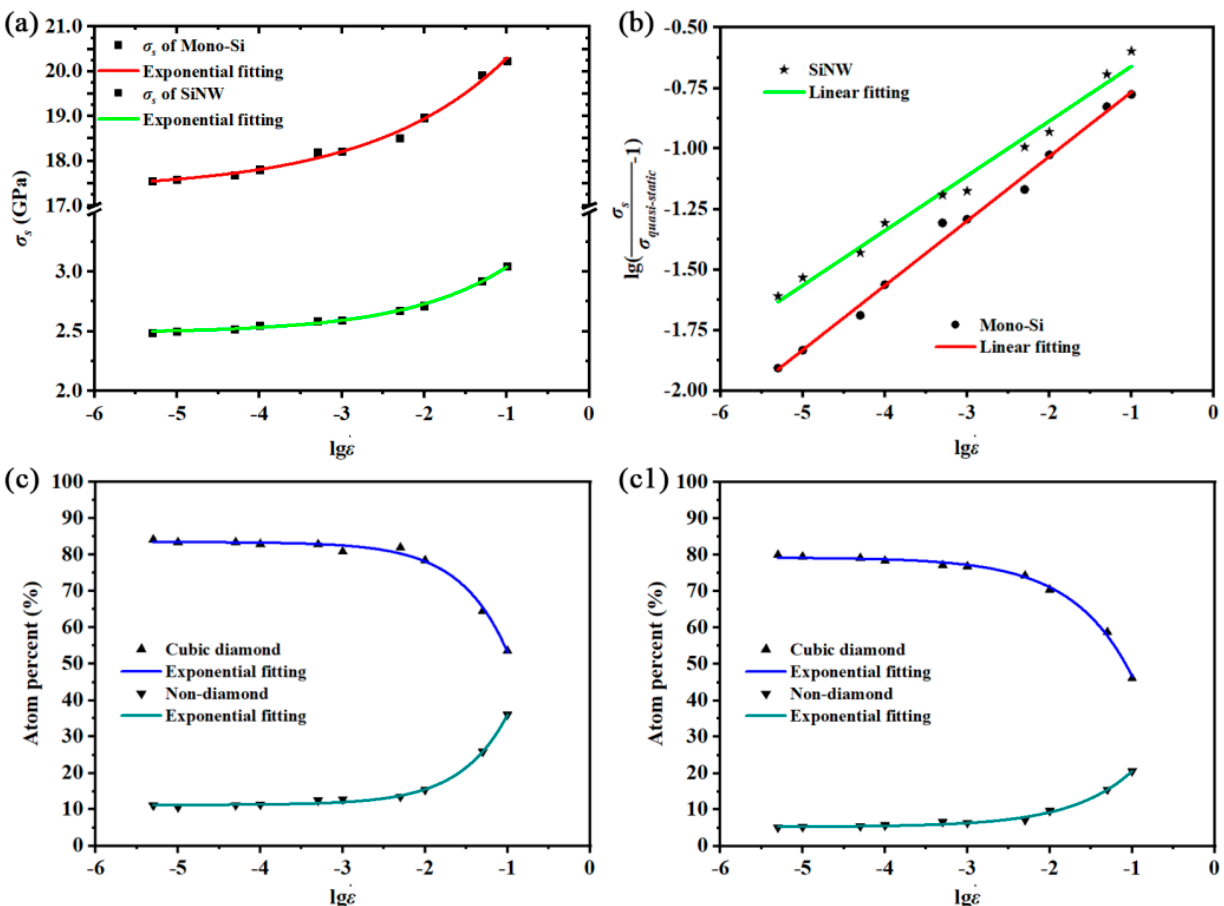
. . − 1 ) ; ( c ) variations of non-diamond atoms Figure 3. ( a ) lg ε versus σ s ; ( b ) lg ε versus lg ( σ s σ σ quasi - static ε  ε  − s Figure 3. ( a ) lg versus σ s ; ( b ) lg versus lg ( 1) ; ( c ) variations of non-diamond atoms σ − quasi static and cubic diamond atoms of Mono-Si after fracture; ( c1 ) variations of non-diamond atoms and cu- bic diamond atoms of SiNW after fracture.